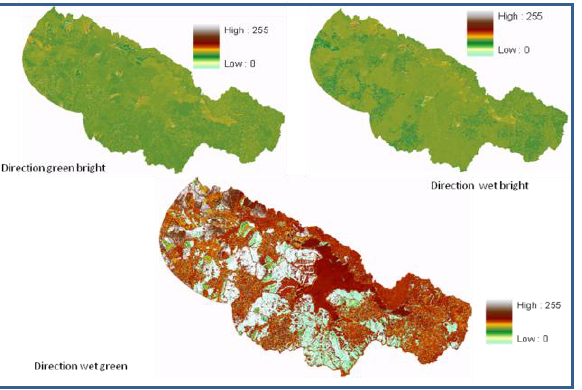
Figure 5. Direction images produced by mCVA Longitude vector direction (direction green/bright) image shows a large brightness increase in the vegetated areas. Barren lands Figure 3. Change vector magnitude representing the intensity of show increase in brightness. Conversely, most of the semi change between a pixel’s brightness, greenness, and wetness in natural and mixed forest communities register a vector direction 2003 and 2007. change towards the greenness axis. The colatitude vector direction (direction wet/green) image shows very small vector